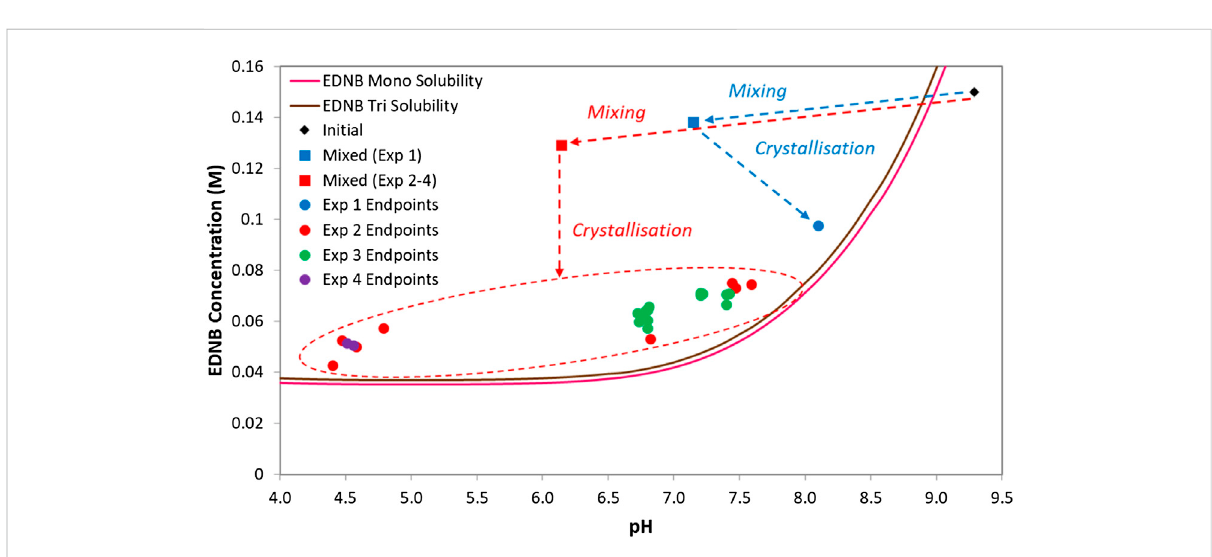
FIGURE 8 Crystallisationprocessesforallofthecontinuousmixerexperiments.Experiments1-3utilisedtheco-axialmixerwhileexperiment4utilisedthe Ehrfeld modular microreactor system with valve mixer.